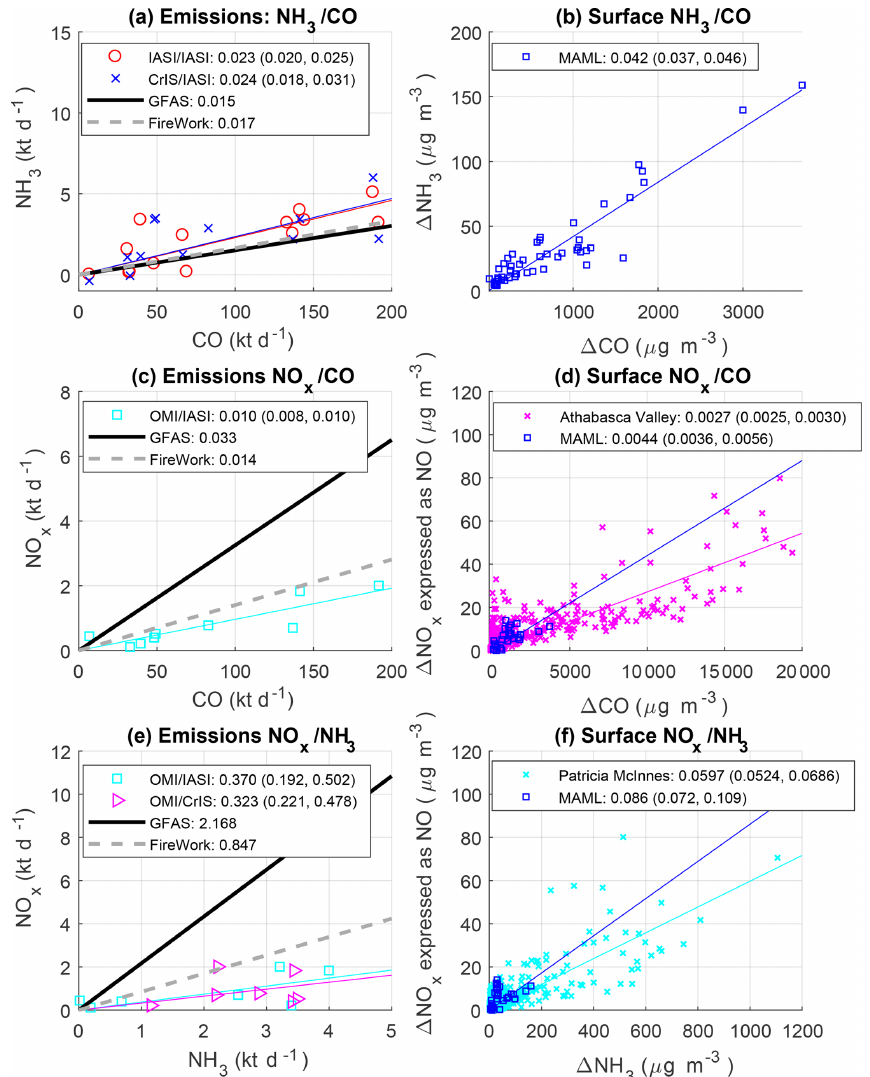
Figure 9. Scatter plots of emissions (a, c, e) and surface concentrations (b, d, f) for NH 3 / CO (a, b) , NO x / CO (c, d) , and NO x / NH 3 (e, f) . Daily emissions are shown for satellite and the GFAS and FireWork models. The differences in surface concentrations are hourly averages minus background concentrations. The slope and 95% confidence interval (given in brackets) of a linear fit constrained to go through the origin are also shown in the